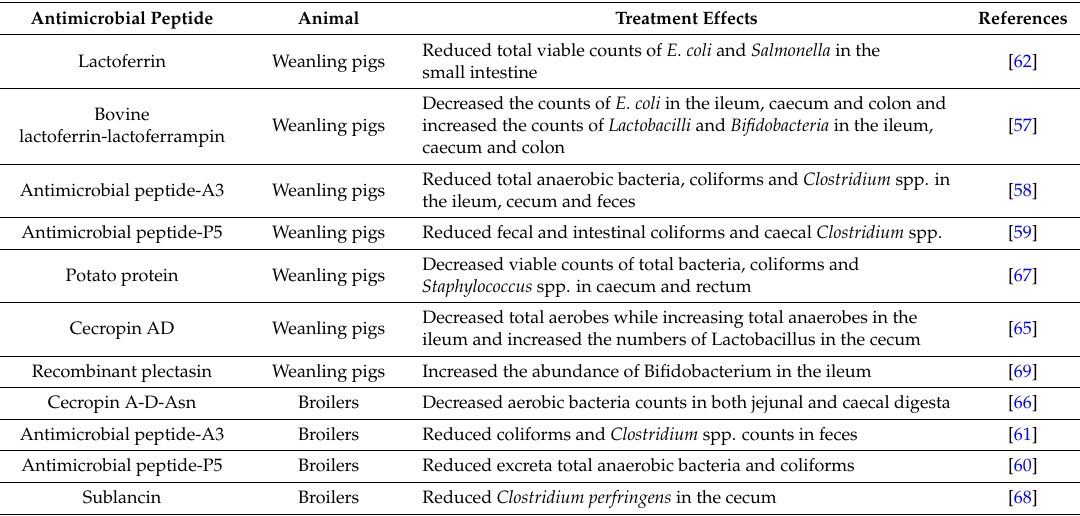
Table 3. Effects of antimicrobial peptides on the gut microbiota in swine and poultry. Antimicrobial Peptide Animal Treatment